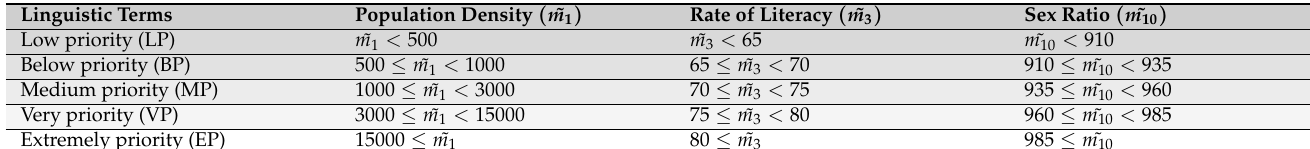
Table 13. Conversion table between fixed data to linguistic terms.